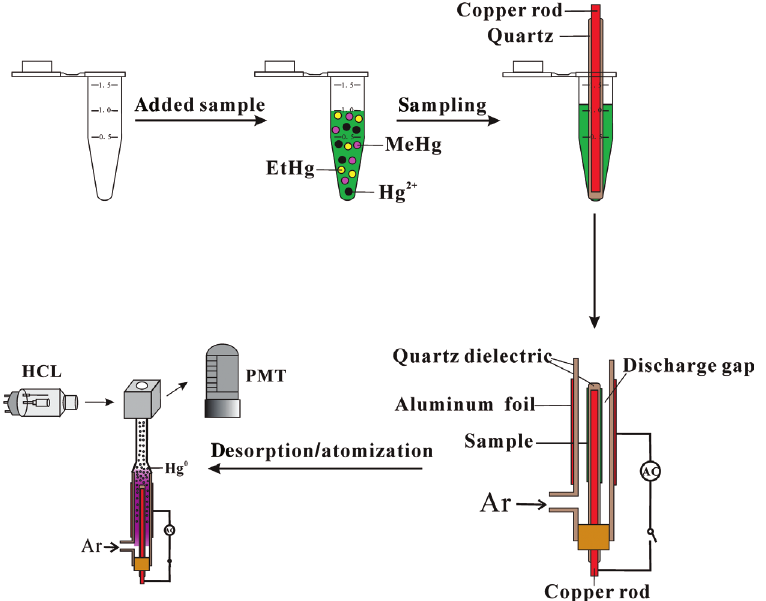
Figure 4 Schematic diagram of DBD-PIV of mercury species. HCL, hollow cathode lamp; PMT, photomultiplier. Reproduced from Liu et al. (2011) with permission of the Royal Society of